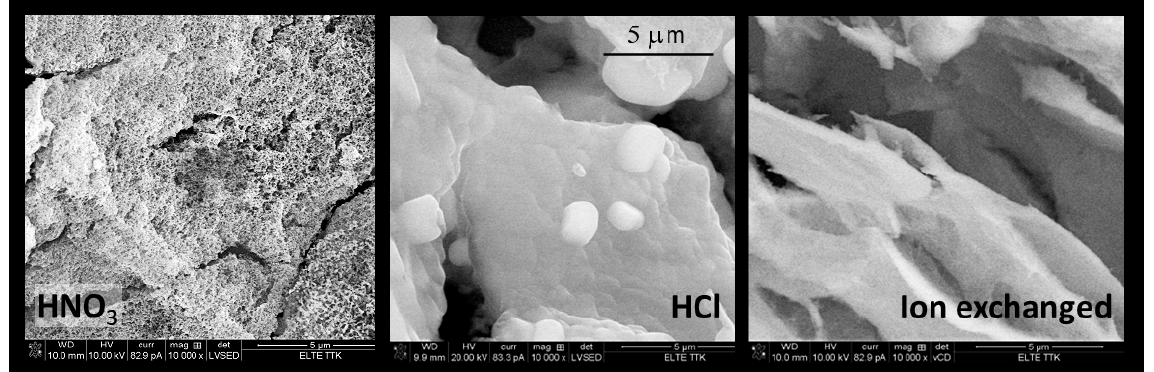
Figure 2. SEM images of cryogel prepared from water glass. The pH is regulated by HNO 3 , HCl, and ion exchange. Magnification is 10,000× g .